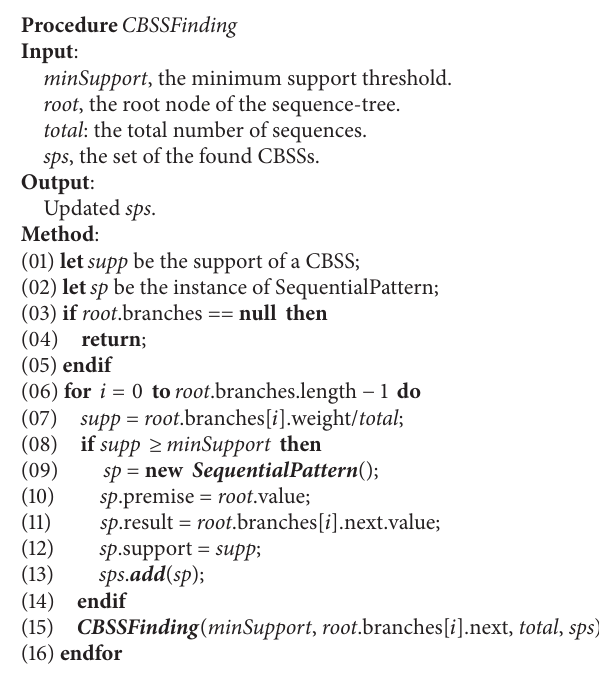
Algorithm 4: CBSSFinding .